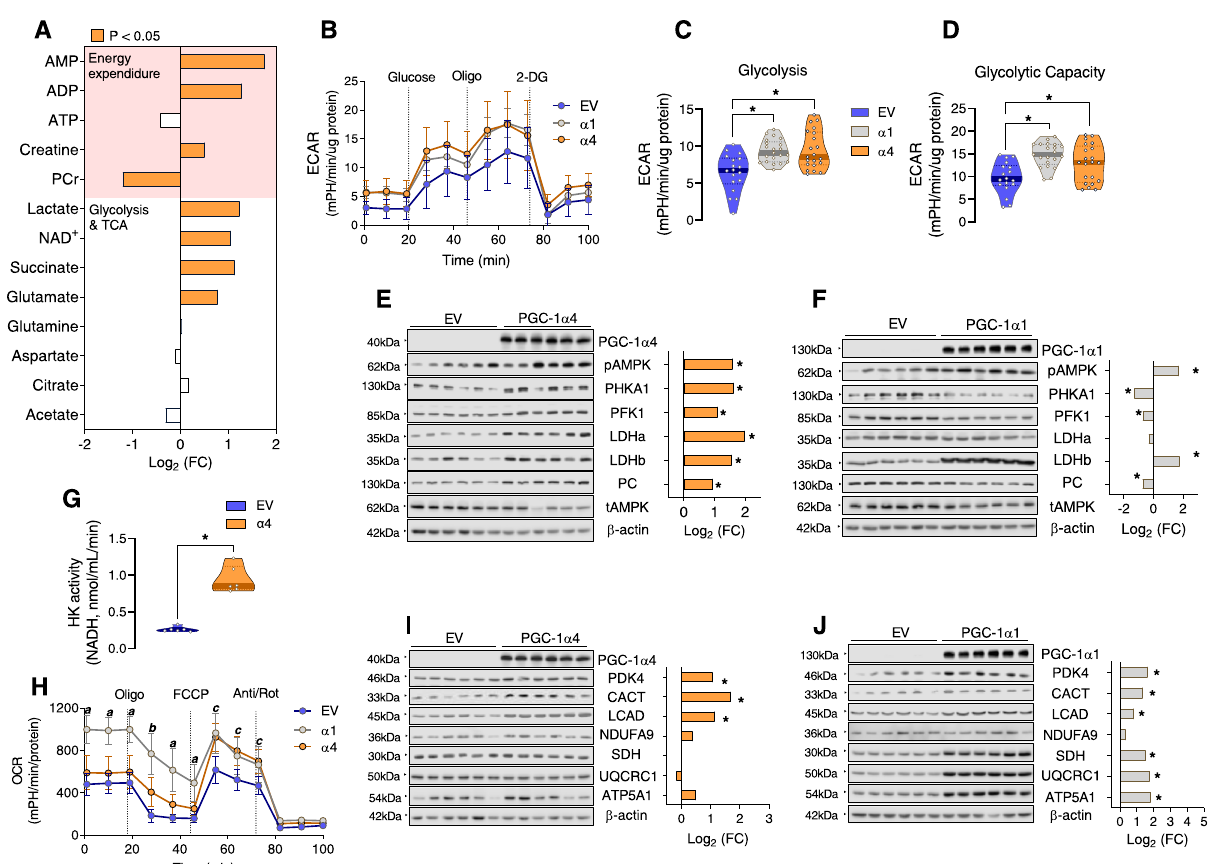
Fig. 3 Overexpressing PGC-1 α 4 in mouse myotubes enhances glycolysis. A Bioenergetic metabolites were analyzed by NMR in myotubes transfected with an empty vector or an adenovirus overexpressing PGC-1 α 4 ( n = 6 per group). Data are presented as log 2 fold-change (FC) induced by PGC-1 α 4 overexpression. The orange colored bars represent a signi fi cantly changed value ( P < 0.05). B – D Glycolysis was measured in myotubes following PGC-1 α 1 ( α 1) or PGC-1 α 4 ( α 4) overexpression using a Seahorse instrument. Values from α 1 and α 4 myotubes were compared to myotubes transfected with and empty vector (EV). Glucose, oligomycin (an inhibitor of oxidative phosphorylation which blocks ATP synthase), and 2-Deoxy- D -glucose (2-DG) were sequentially added to identify the change in extracellular acidi fi cation rate (ECAR). Glycolysis (measured in cells during exposure to glucose) and Glycolytic capacity (measured after exposure to oligomycin) were assessed by computing area under the curve using software of the Seahorse analyzer. One-way ANOVA was used with multiple comparisons. E , F The abundances of glycolysis-related proteins were analyzed following α 4 and α 1 overexpression in myotubes by immunoblotting. Unpaired two-tailed t -tests were used. G Hexokinase activity was measured in myotubes transfected with EV or α 4. Unpaired two-tailed t-tests were used. H Oxygen consumption rate (OCR) was determined in myotubes overexpressing α 4 or α 1, and myotubes transfected with an EV by Seahorse analyzer. Oligomycin, FCCP (uncoupler), and antimycin/rotenone were sequentially added, and OCR was measured. At P < 0.05, “ a ” indicates that α 1 > EV and α 4; “ b ” indicates that α 1 > EV and α 4, but also α 4 > EV; and “ c ” indicates that both α 1 and α 4 > EV. One-way ANOVA was used with multiple comparisons. I , J The abundance of fatty acid metabolism-related proteins and mitochondrial enzymes were analyzed following overexpression of α 4 or α 1 in myotubes by immunoblotting. Data are presented as log 2 fold-change (FC) by PGC-1 α isoform overexpression versus EV controls ( n = 6 per group). Unpaired two-tailed t -tests were used. * P < 0.05 versus EV. Values are expressed as individual data points, Log 2 FC, or mean ± SD. Signi fi cant labeled P -values in each panel from left to right are as follows: panel C = < 0.001 and <0.001; panel D = < 0.001 and 0.017; panel G = <